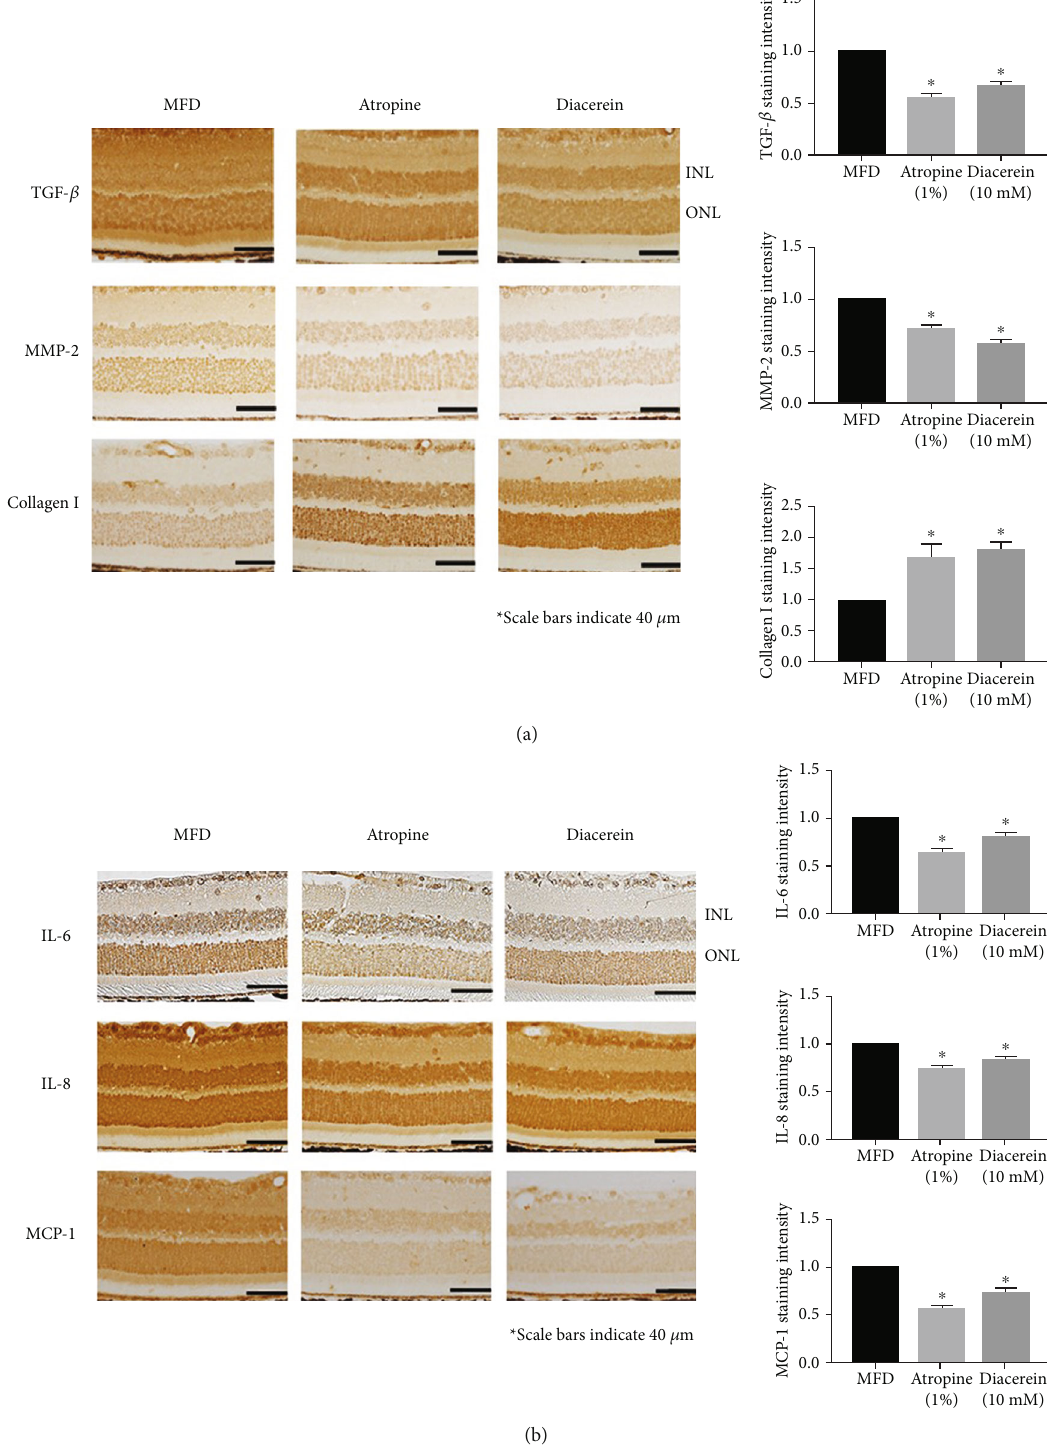
Figure 2: Diacerein a ff ects expression levels of in fl ammation-related proteins in MFD hamsters. (a) Immunohistochemical analysis of TGF- β 1 , MMP-2, and type I collagen expression in MFD control eyes (right eye MFD), 1% atropine-treated MFD eyes (right eye atropine), and 10 mM diacerein-treated MFD eyes (right eye diacerein). INL: inner nuclear layer; ONL: outer nuclear layer. (b) Immunohistochemical analysis of IL-6, IL-8, and MCP-1 expression in MFD control eyes (right eye MFD), 1% atropine-treated MFD eyes (right eye atropine), and 10mM diacerein-treated MFD eyes (right eye diacerein). INL: inner nuclear layer; ONL: outer nuclear layer. ANOVA was used for paired comparisons between control, atropine (1%), and diacerein (10 mM). The data are expressed as mean ± SD of three independent experiments. ∗ p < 0 : 05 compared to the control